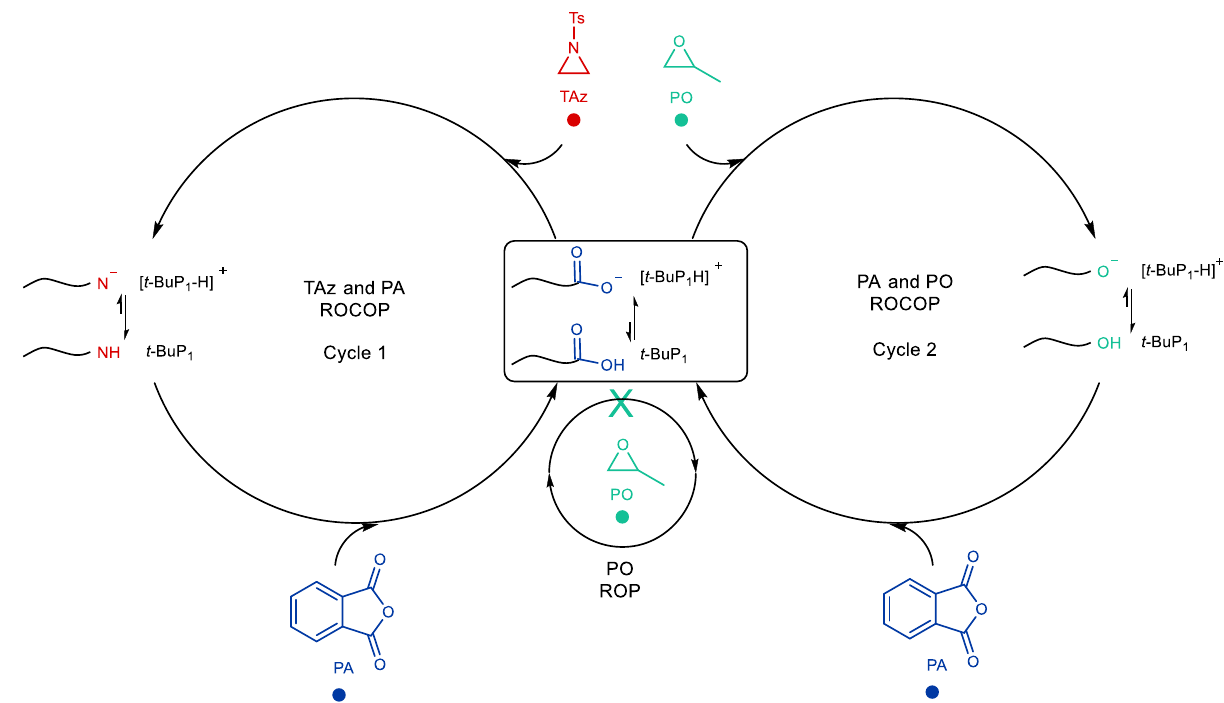
Fig. 7 Proposed terpolymerization pathways. Chemoselective TAz/PA ROCOP and PA/PO ROCOP by a simple organocatalyst, t -BuP 1